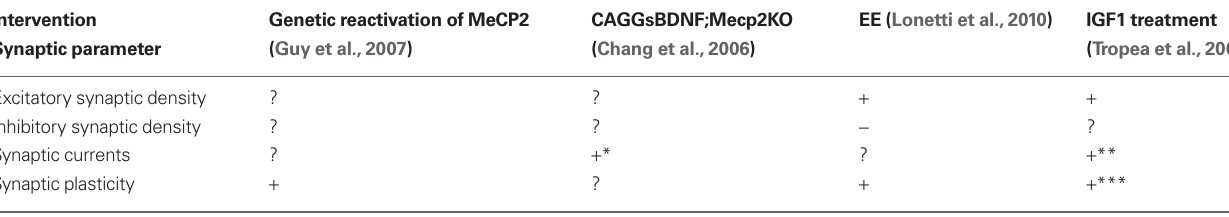
Table 3 | Synaptic effects of pharmacological and behavioral treatments in MeCP2 mutant mice. intervention Genetic reactivation of MeCP2